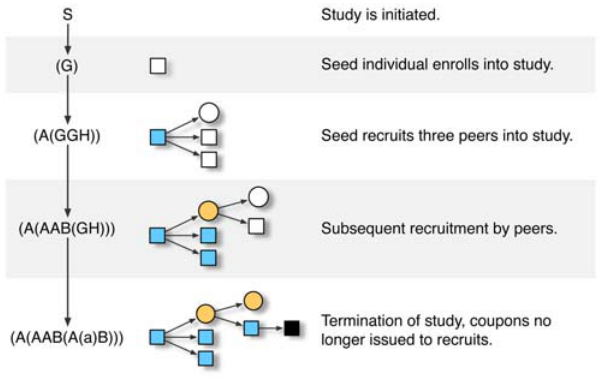
Figure 1. Relating a stochastic context-free grammar (SCFG) to the multitype branching process of RDS. Strings generated by an SCFG are depicted on the left-hand side. S is the start symbol from which all strings are derived, corresponding to the initiation of an RDS study; G and H are non-terminal symbols for different types of respondents whose recruitment outcomes are unresolved; and A and B are terminal symbols for respondents whose recruitment outcomes are resolved. A successful recruitment is indicated by a substring enclosed in parentheses to the immediate right of the originating terminal symbol. To represent the termination of an RDS study, the remaining non-terminal symbols are rewritten as lower-case terminal symbols, e.g. , a